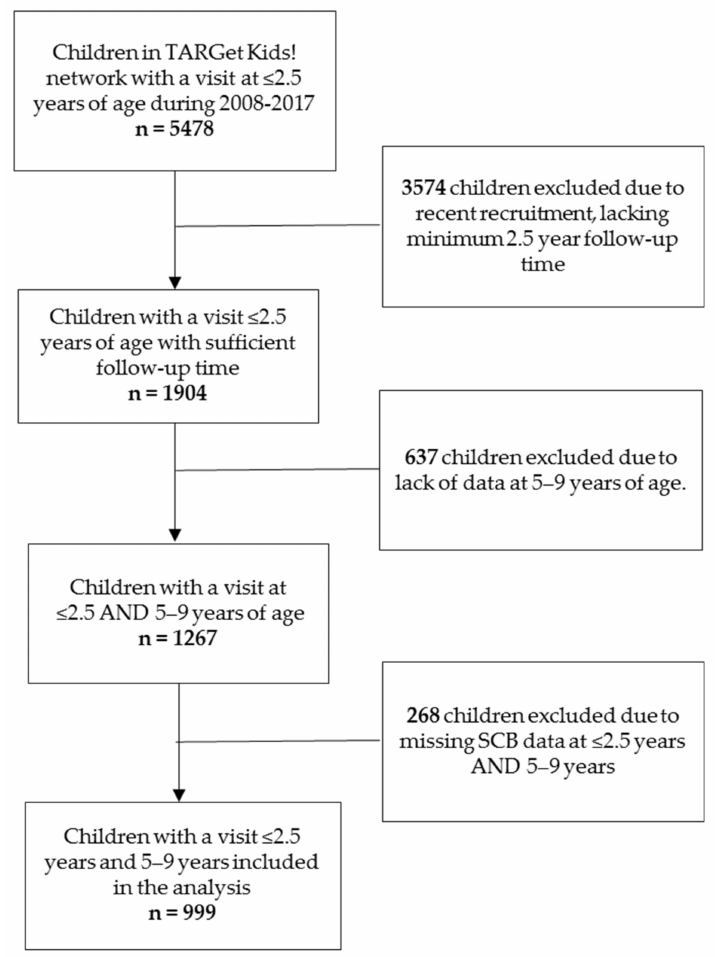
Figure 1. Participant flow